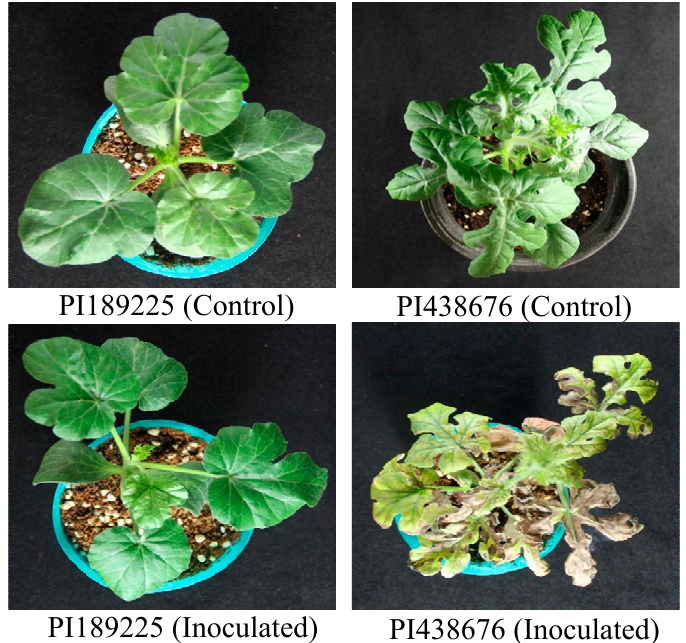
Figure 8. Phenotypes of watermelon lines PI189225 (resistant) and PI438676 (susceptible) after inoculation with Didymella bryoniae.